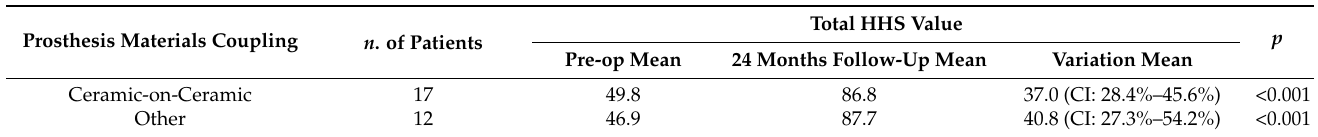
Table 6. Total Harris Hip Score (HHS) pre-op vs 24 months’ follow-up values in subgroups of prosthesis materials coupling type.